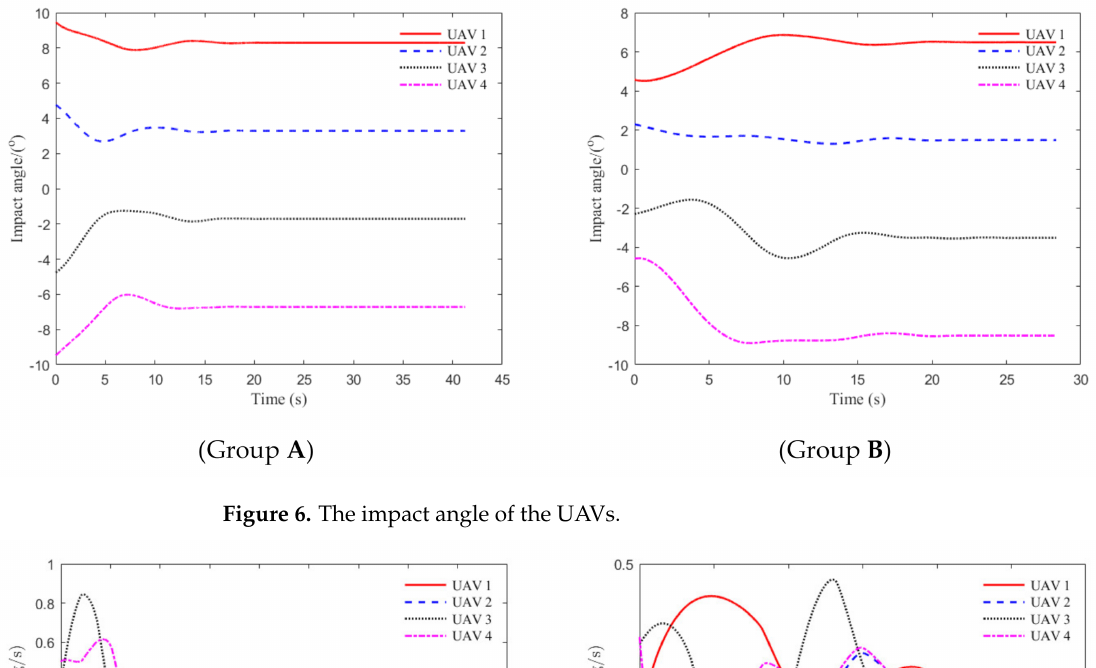
Figure 5. Radial relative velocities between four UAVs and a maneuvering target.